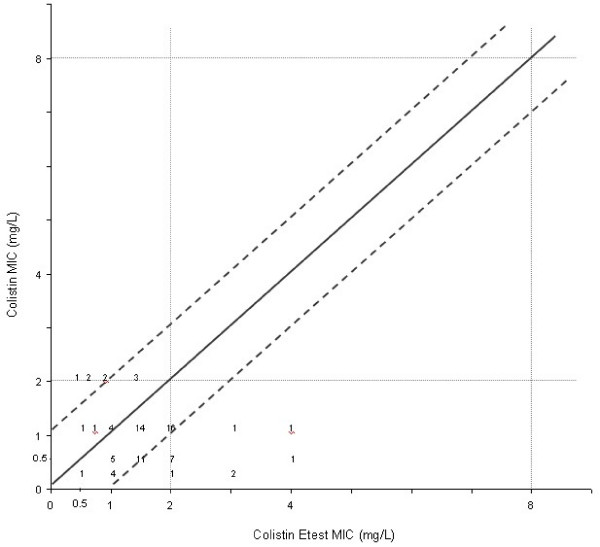
Scattergram results comparing colistin MICs determined by Etest with those by the broth microdilution reference method (n = 78). The diagonal black line represents complete agreement, and the numbers represent the occurrences observed at each point. The broken lines represent ± 1-log2 MIC agreement limits between test results. Horizontal and vertical broken lines indicate the resistant MIC breakpoint ≥8 mg/L) [10].